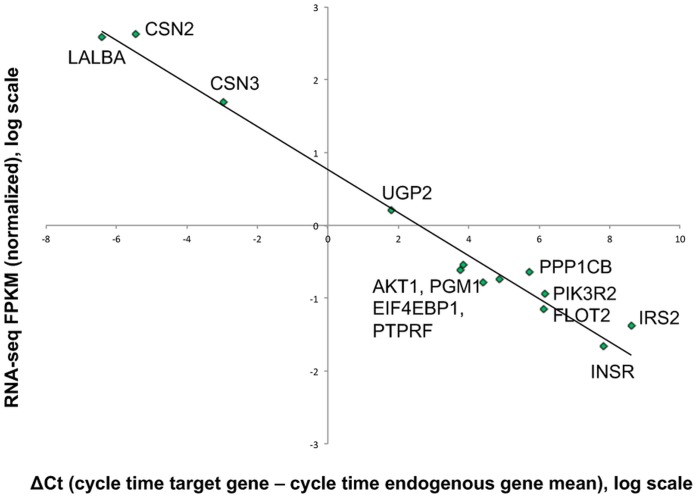
Confirmation of RNA-Seq results with qPCR results.Data derived from average of 4 milk fat layer samples obtained during mature lactation. Results are plotted on a log scale for both axes. X-axis: qPCR ΔCt (target gene, cycle threshold - geometric mean of endogenous genes, cycle threshold); Y-axis: RNA-seq FPKM (target gene FPKM/geometric mean of endogenous genes FPKM). Endogenous genes selected: ACTB, RPS18, SSH3. Correlation of gene expression measured by qPCR versus RNA-seq, R2 = 0.98, p<0.001.